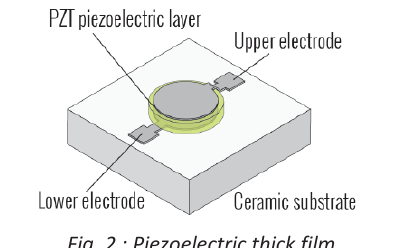
Fig. 2 : Piezoelectric thick film